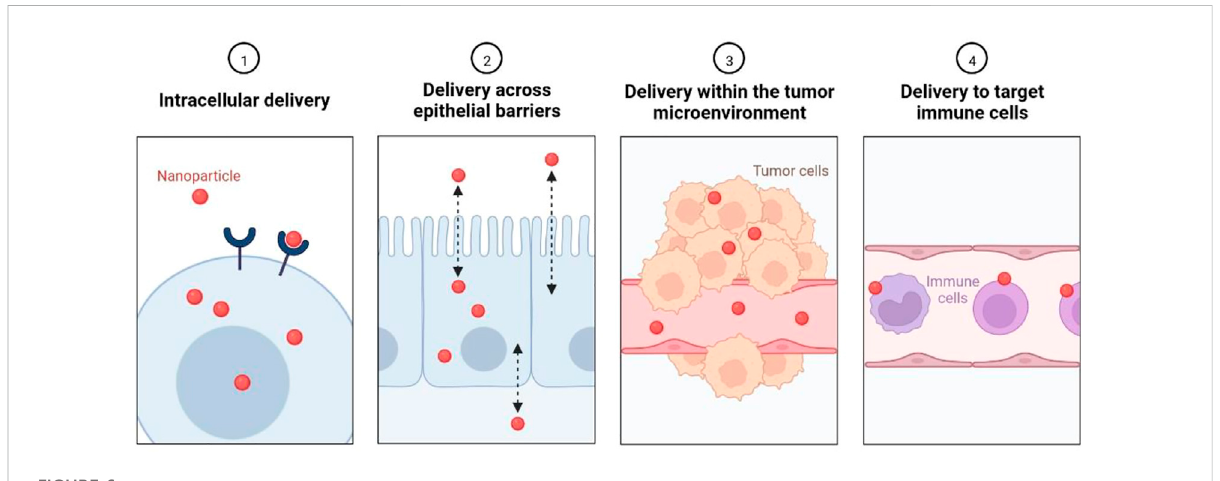
Biological barriers that nanoparticles can help